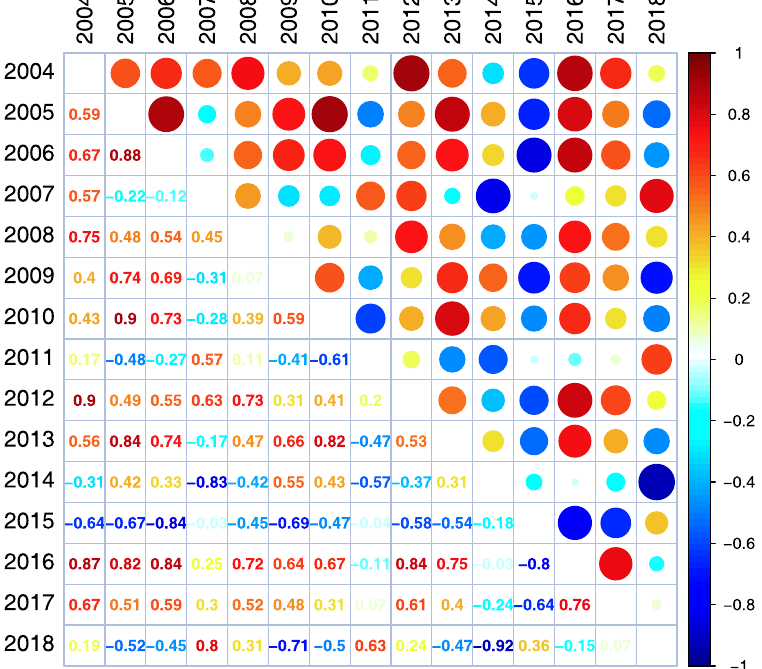
Figure 8. Pearson correlation matrix for time series of detrended groundwater levels corresponding to the hydrological years (HYs).